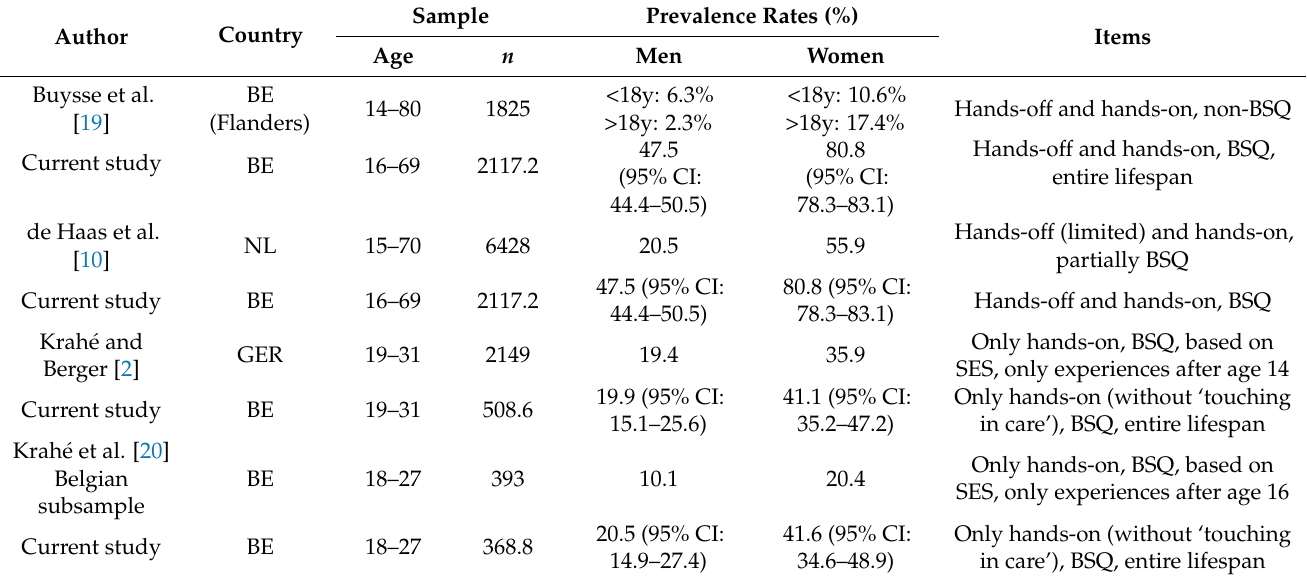
Table 8. Comparison of prevalence studies on sexual lifetime